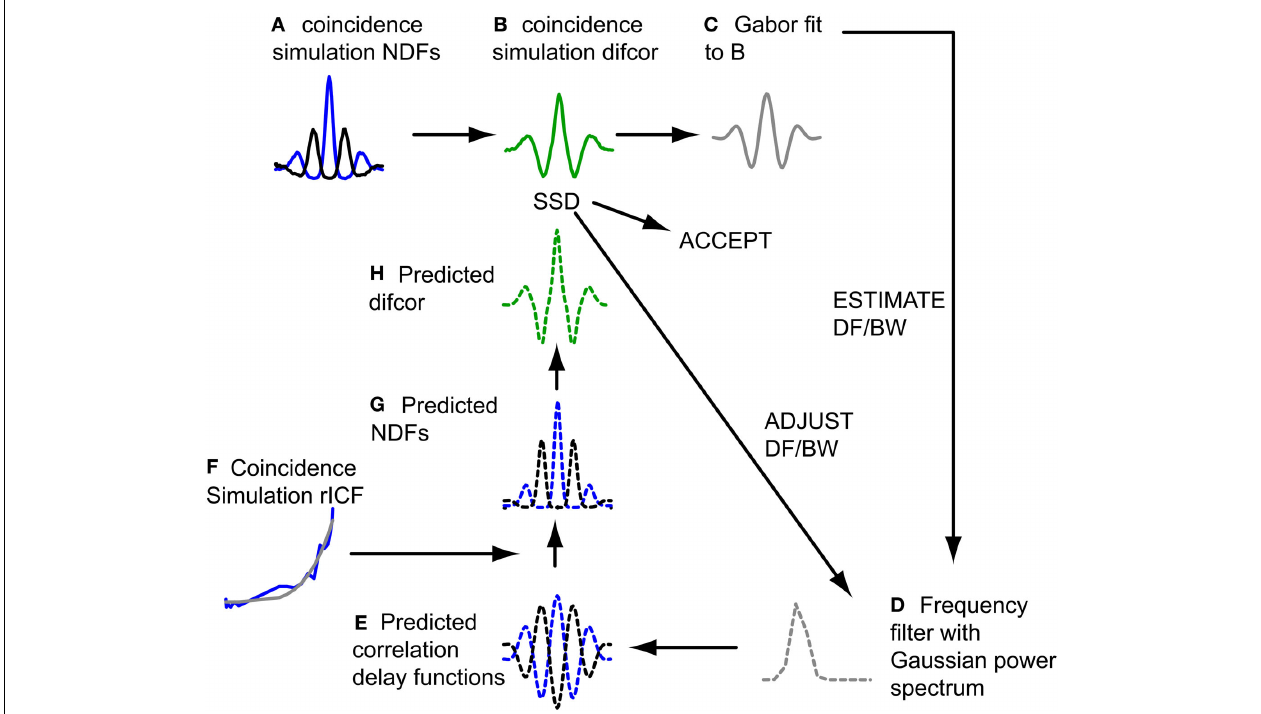
FIGURE 2 | Fitting procedure of NDFs to estimate DF and BW. Dashed lines indicate filter model. Blue lines represent ρ = 1, black lines represent ρ = − 1. See text for detailed explanation of steps (A–H)